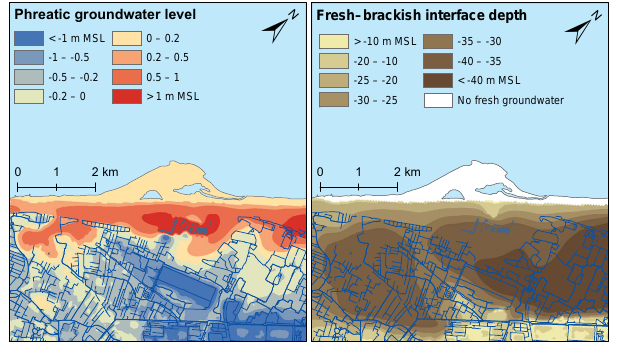
Figure 8. Phreatic groundwater level (left) and fresh–brackish in- terface depth (right) after calibration, before the construction of the Sand Engine (2010–2011).